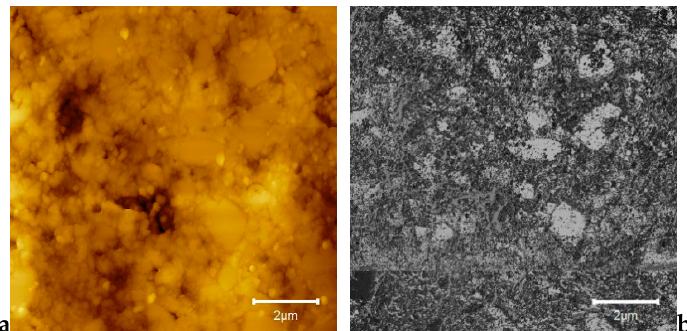
a b a b a b Figure 6. 10 × 10 µ m 2D atomic force microscopy (AFM) images of the 3D-printed E-Dent 100 sample: Figure 6. 10 × 10 µm 2D atomic force microscopy (AFM) images of the 3D-printed E-Dent 100 sample: Figure 6. 10 × 10 µm 2D atomic force microscopy (AFM) images of the 3D-printed E-Dent 100 sample: ( a ) topography; ( b ) phase contrast. ( a ) topography; ( b ) phase contrast. Figure 6. 10 × 10 µm 2D atomic force microscopy (AFM) images of the 3D-printed E-Dent 100 sample: ( a ) topography; ( b ) phase contrast. ( a ) topography; ( b ) phase contrast.